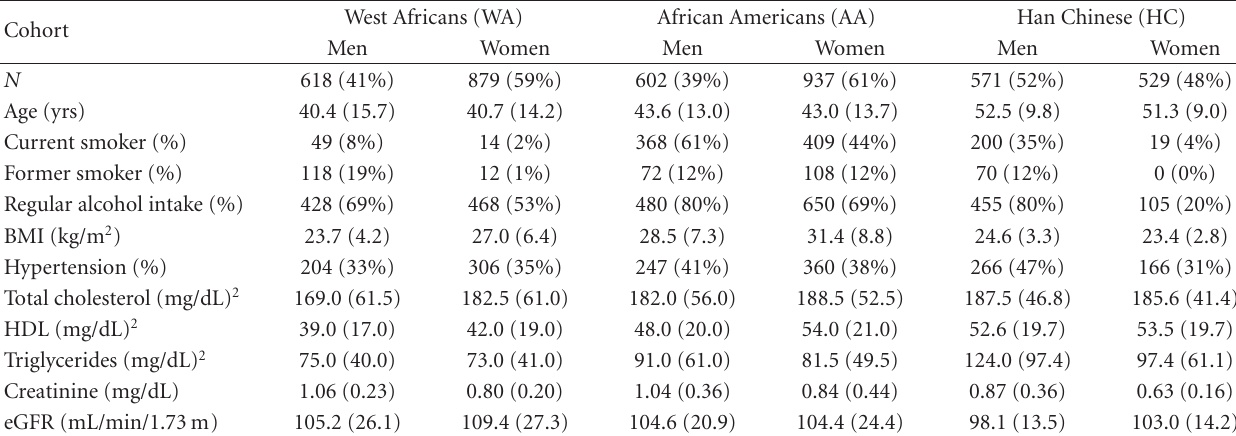
Table 1: Participant characteristics by cohort 1 .